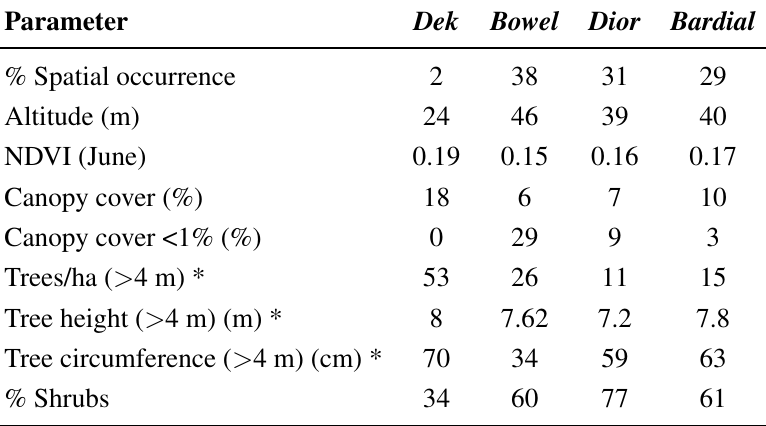
Table 3. Mean vegetation parameters classified according to the 4 clustered soil types derived for test sites from field data (*) and for the whole study area from remote sensing